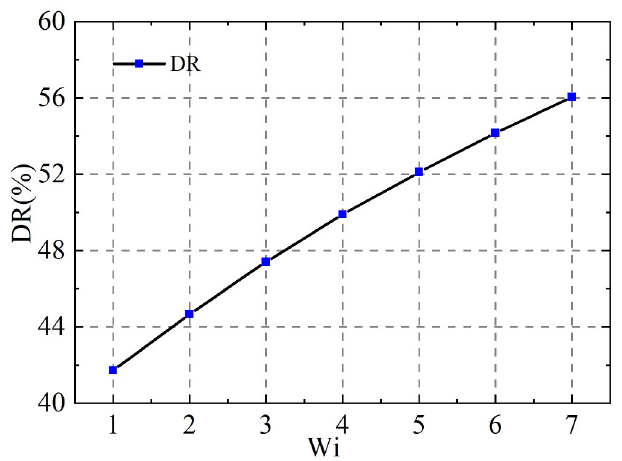
Figure 14. Drag reduction rate of different Weissenberg numbers ( Wi ).